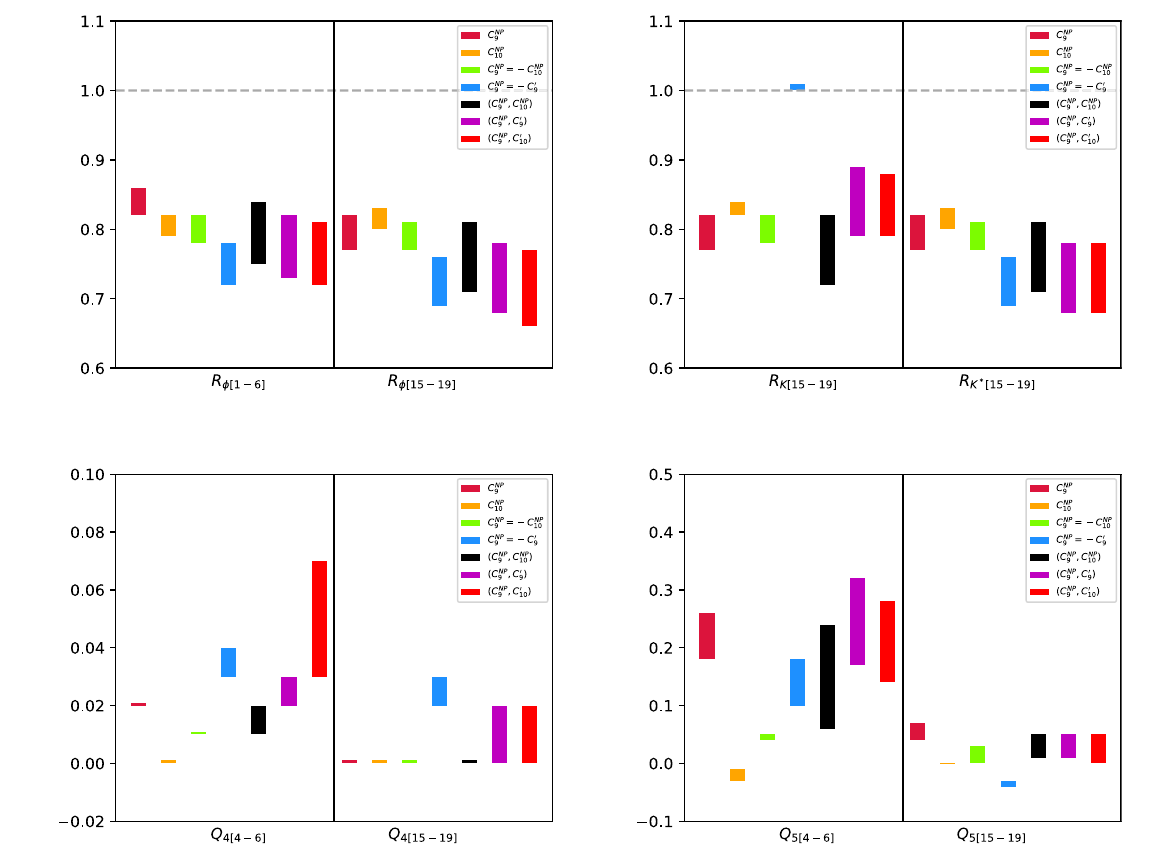
Fig. 2 Prediction (1 σ range) of additional LFUV observables for “1D” and “2D” solutions